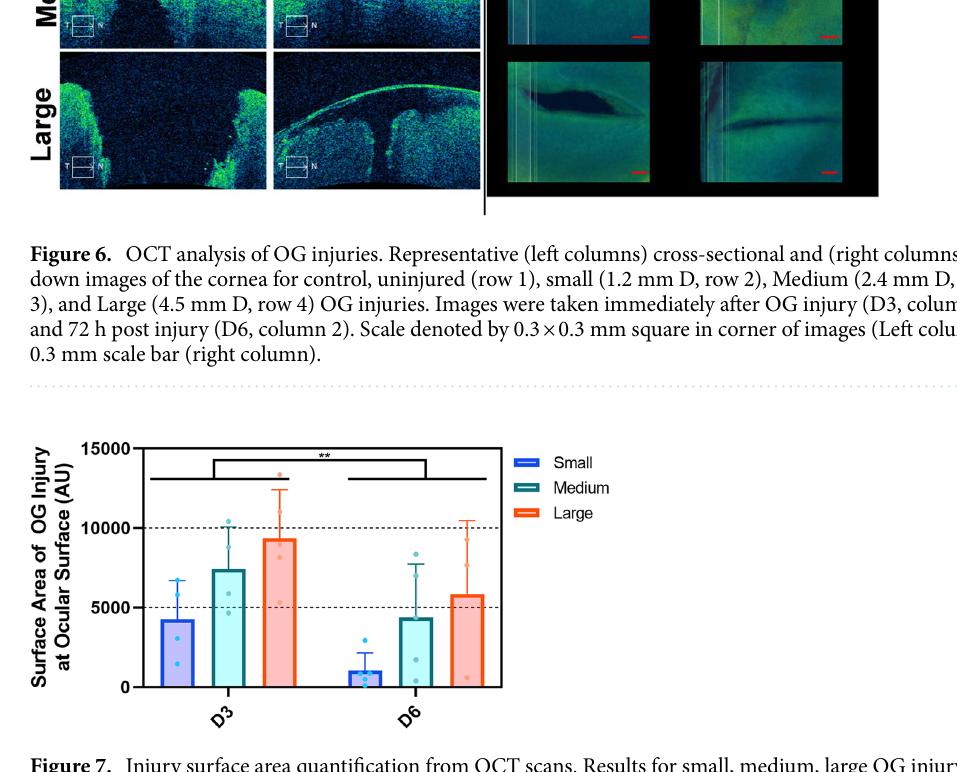
Figure 7. Injury surface area quantification from OCT scans. Results for small, medium, large OG injury size are shown immediately post injury (D3) and 72 h post injury (D6). Data are shown as mean value with error bars denoting standard deviation. Asterisks denote (*) p < 0.05, (**) p < 0.01, (***) p < 0.001, and (****) p < 0.0001 as determined by two-way ANOVA, post-hoc Šídák